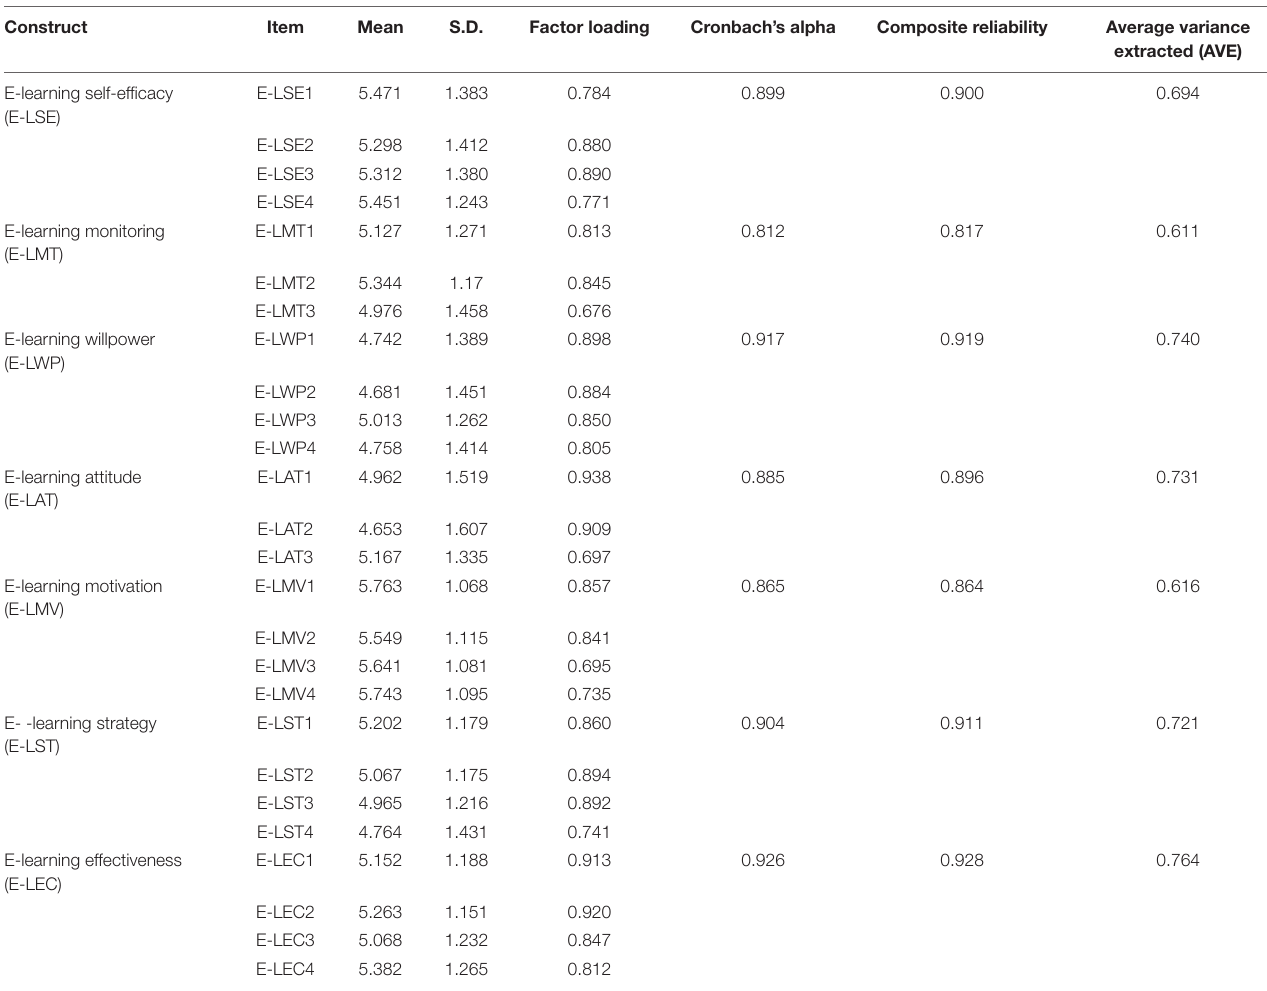
TABLE 2 | Convergent validity of the measurement model.